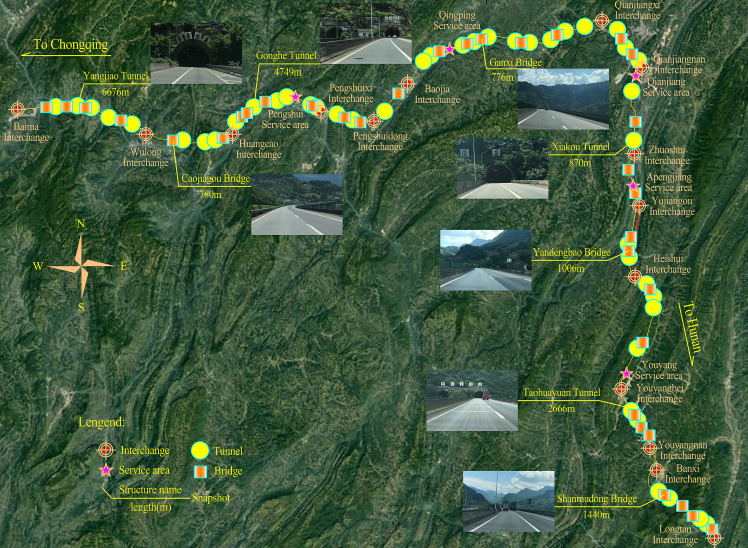
The sketch of selected road section.